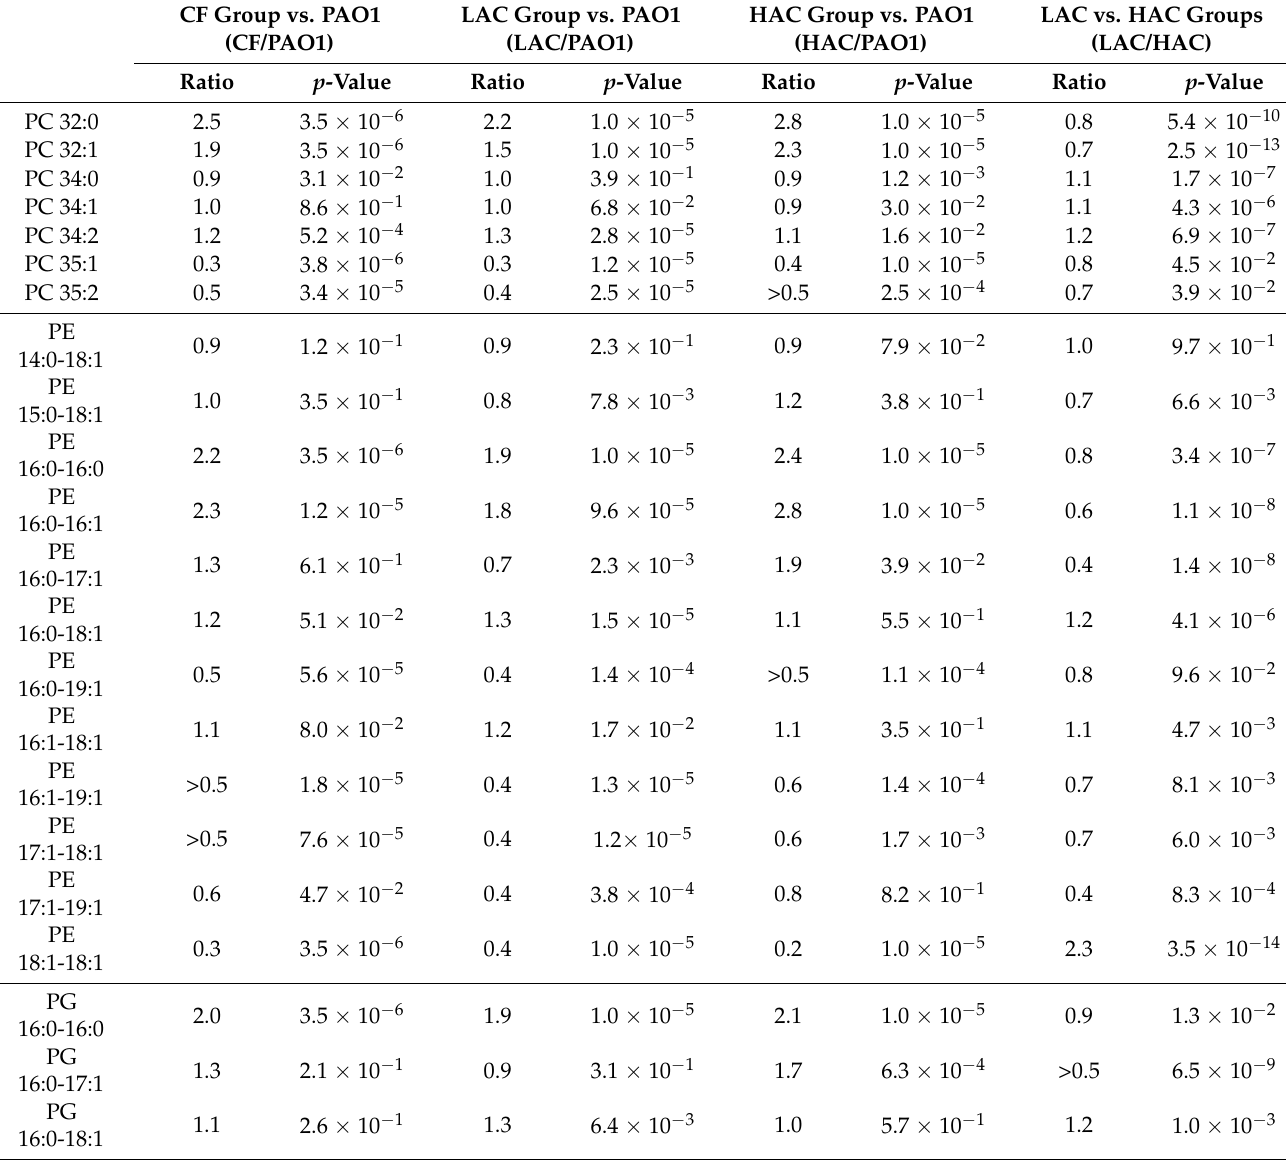
Table 2. Quantitative variations of phospholipids between Pseudomonas aeruginosa strains clustered according to their origin or attachment capacities. Ten clinical isolates were isolated from cystic fibrosis patients and clustered in the so-call “CF group”. This group is composed of two subgroups: The “LAC group” clustering the five clinical strains with the lowest attachment capacities (ACs) and the “HAC group” composed of the five strains with the highest ACs. The phospholipid (PL) profiles of these 10 clinical strains as well as the PL profile of the collection strain PAO1 were determined experimentally by liquid chromatography/tandem mass spectrometry. From these data, in silico phospholipidomes were established for the “CF”, “LAC” and “HAC” groups by averaging for each PL the experimental values of all the strains included in a group. The ratios presented here were calculated from the mean data presented in Table 1 and p -values (Mann–Whitney test) were determined from the data obtained through eight biological replicates/strain (Table S1: PL data